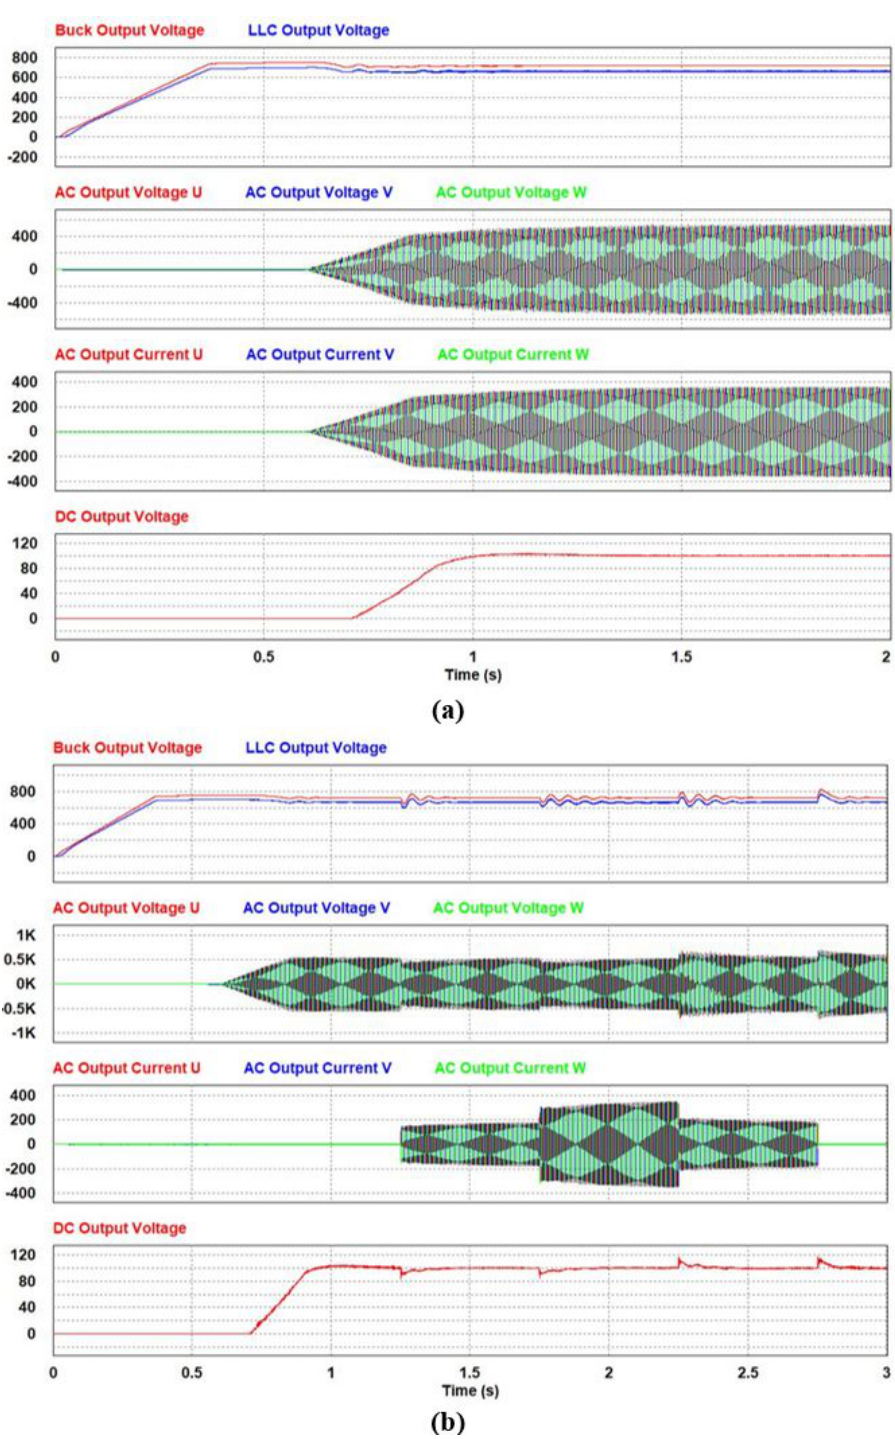
Figure 19. Simulation results of resonant auxiliary power supply for railway